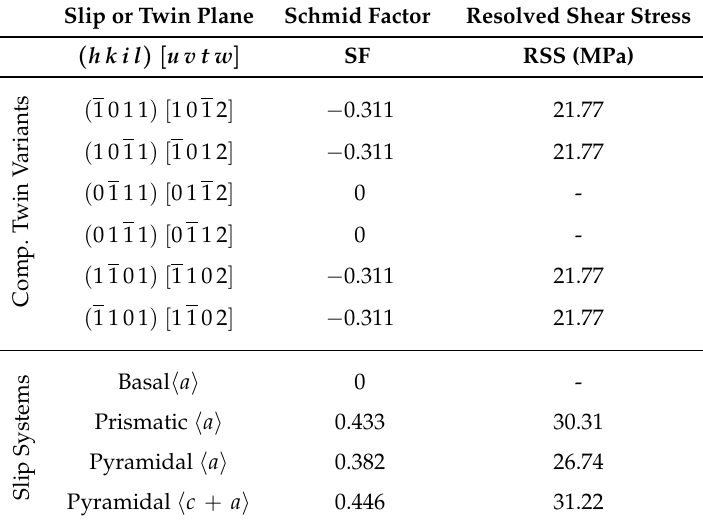
Table 3. Values of resolved shear stress and Schmid factors determined by [ 2110 ] loading with applied stress at 2% strain of ET-Tension in Figure 5.